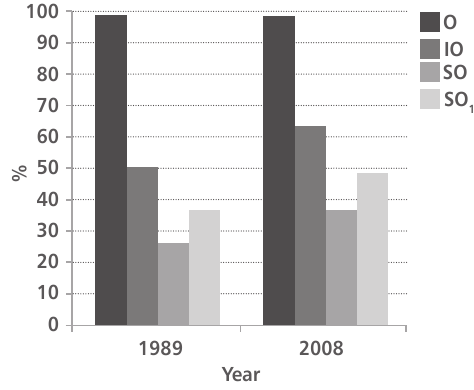
FIGURE 5. Comparison of damage indicators overall for all the interpreted species from two surveying periods